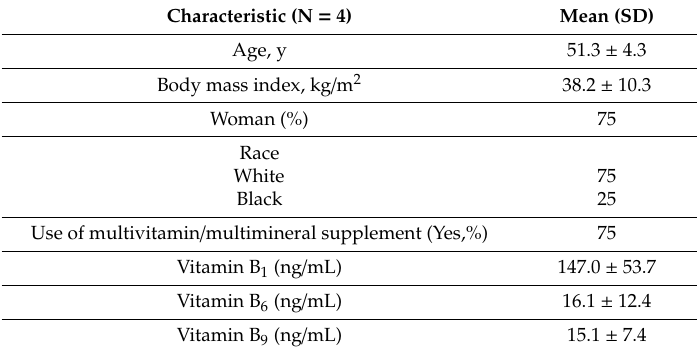
Figure 1. HPLC–MS / MS elution profiles of vitamin analytes. Peaks are labelled with each B vitamin and its specific mass transition ( m / z ). The top panel is the pure standard mixture and the bottom panel is a 100 µ L pooled plasma sample. Table 1. Description of participants who provided pooled plasma